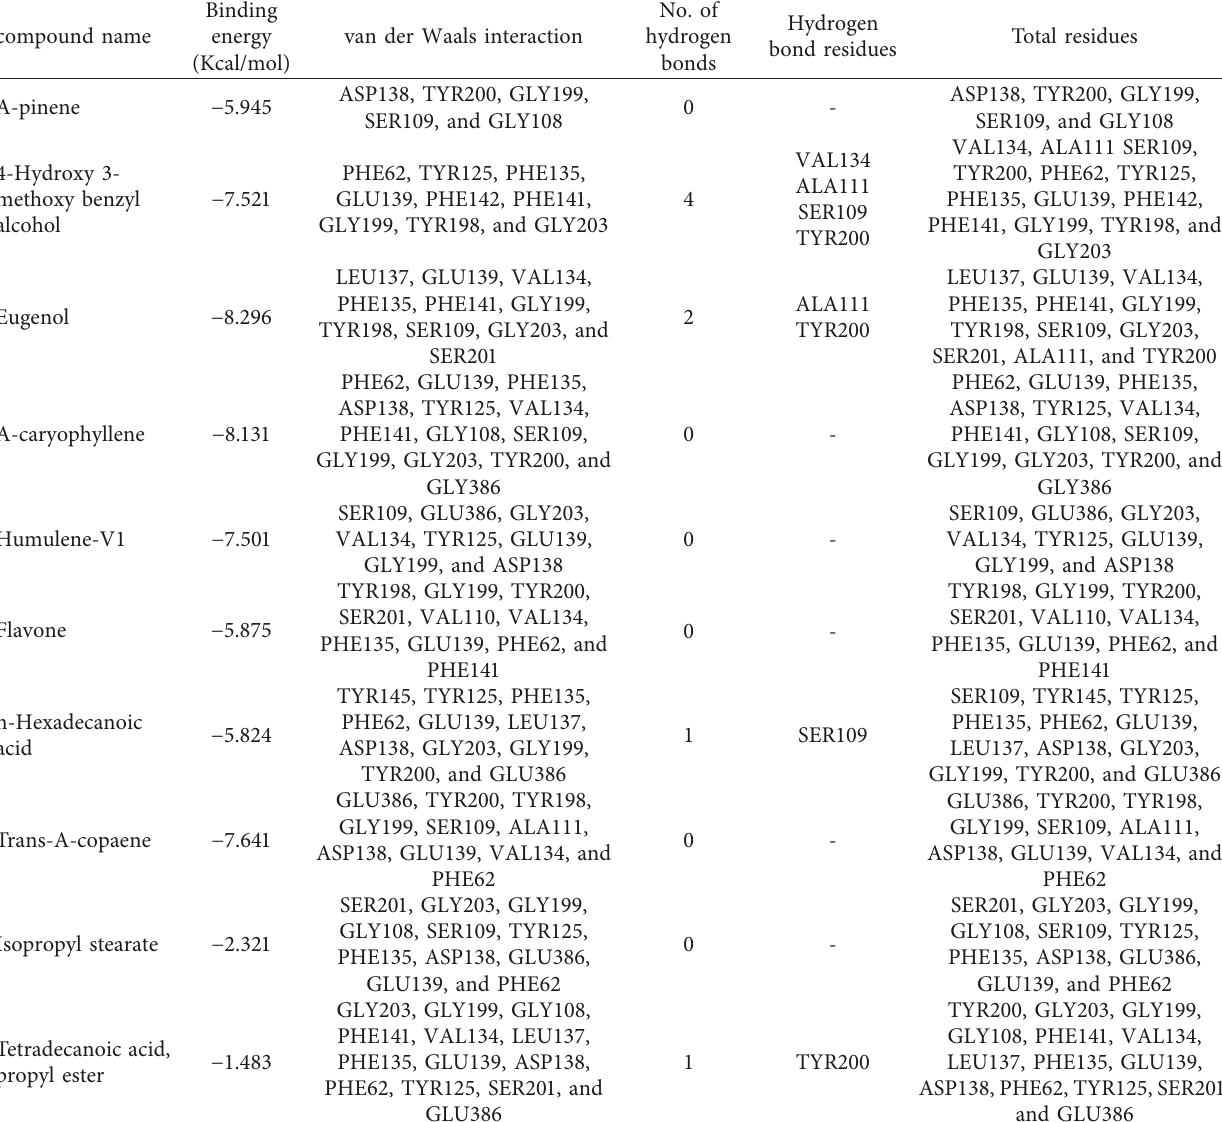
Table 5: Docked conformation of bioactive compounds against lipase of Malassezia